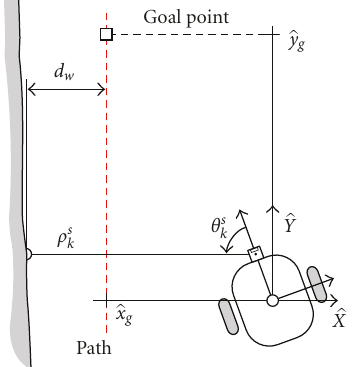
Figure 4: Implicit path estimation and goal point selection for left wall